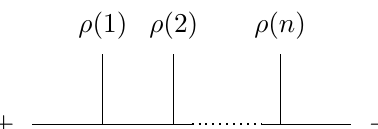
(cid:0) (cid:1) 1 ; (cid:26) (2 ; : : : ; n (cid:0) 1) ; n correspond to half-ladder